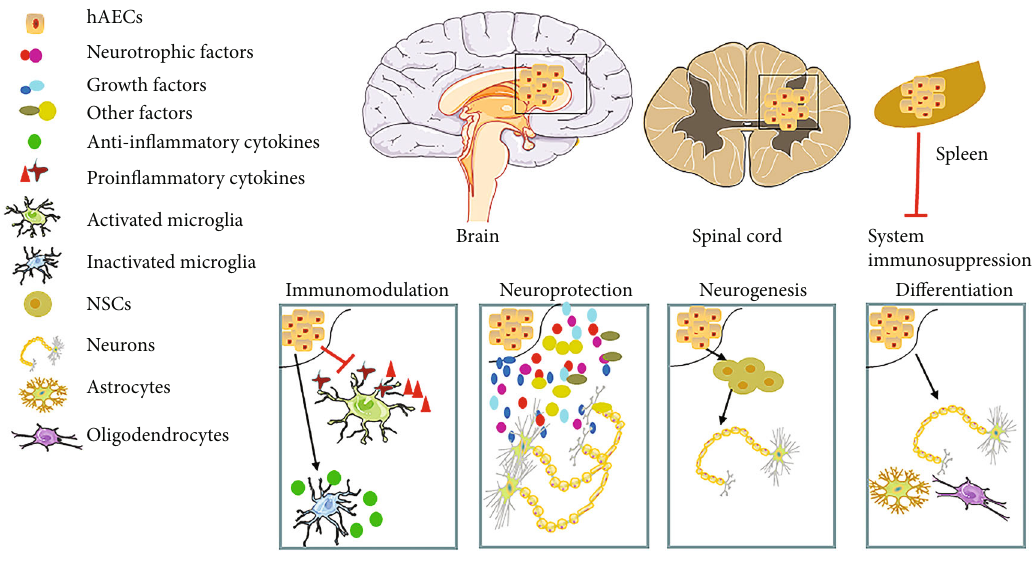
Figure 2: Human amniotic epithelial cell- (hAEC-) based therapy for neurological injuries and diseases. After hAECs are transplanted into the brain by intracerebral or intravenous injection, hEACs migrate to the lesion area of the brain, and the likely therapeutic mechanisms of hAECs in the treatment of neurological injuries and diseases are